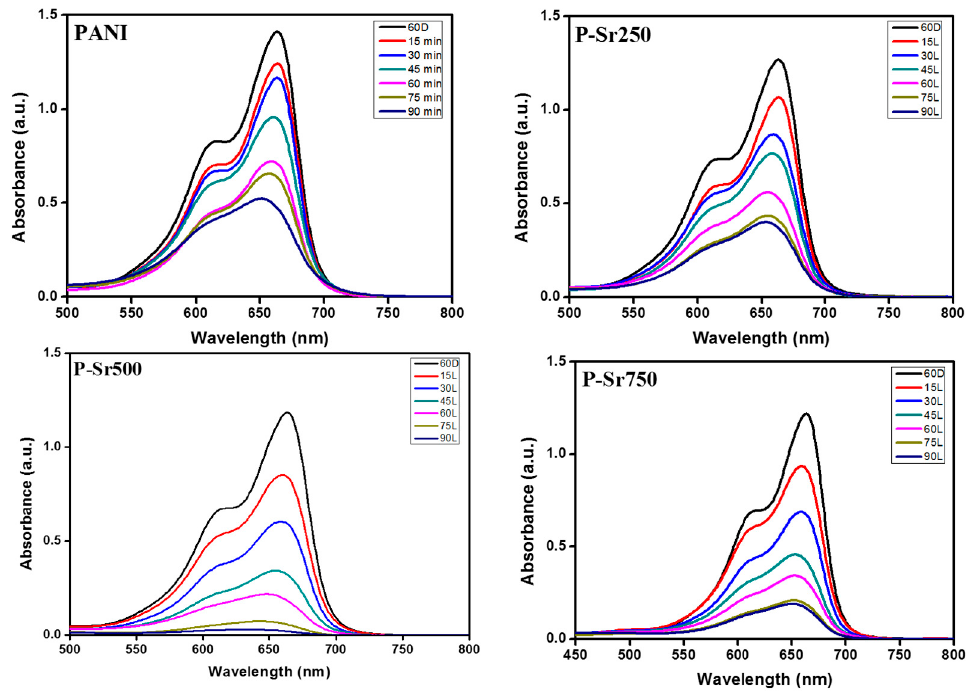
Figure 11. UV–Vis absorption spectra of MB aqueous solution at different times in the presence of different photocatalysts.